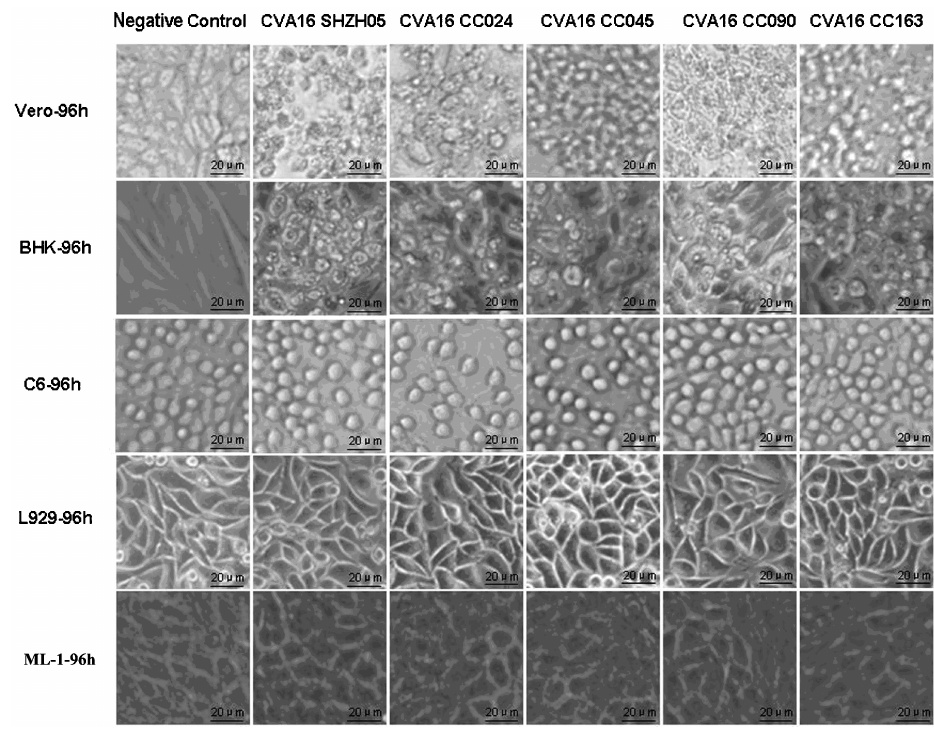
Figure 1. Coxsackievirus A16 (CVA16) replication in vitro . Vero, BHK, C6, L929, and neonatal mouse lung ML-1 cells were infected with the circulating CVA16 Changchun (CC) CC024, CC045, CC090, or CC163 strains or the noncirculating CVA16 SHZH05 strain for 96 h. SHZH05 and all four CC strains caused a cytopathic effect (CPE) in BHK and Vero cells, but not the other three cell